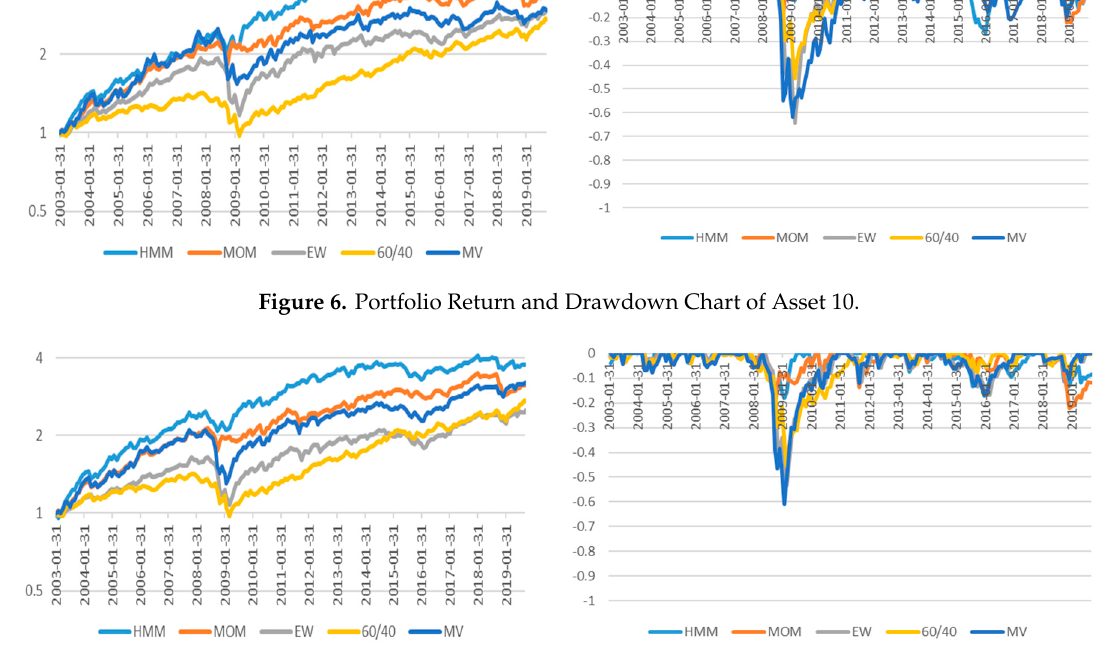
Figure 7 . Portfolio Return and Drawdown Chart of Asset 22.